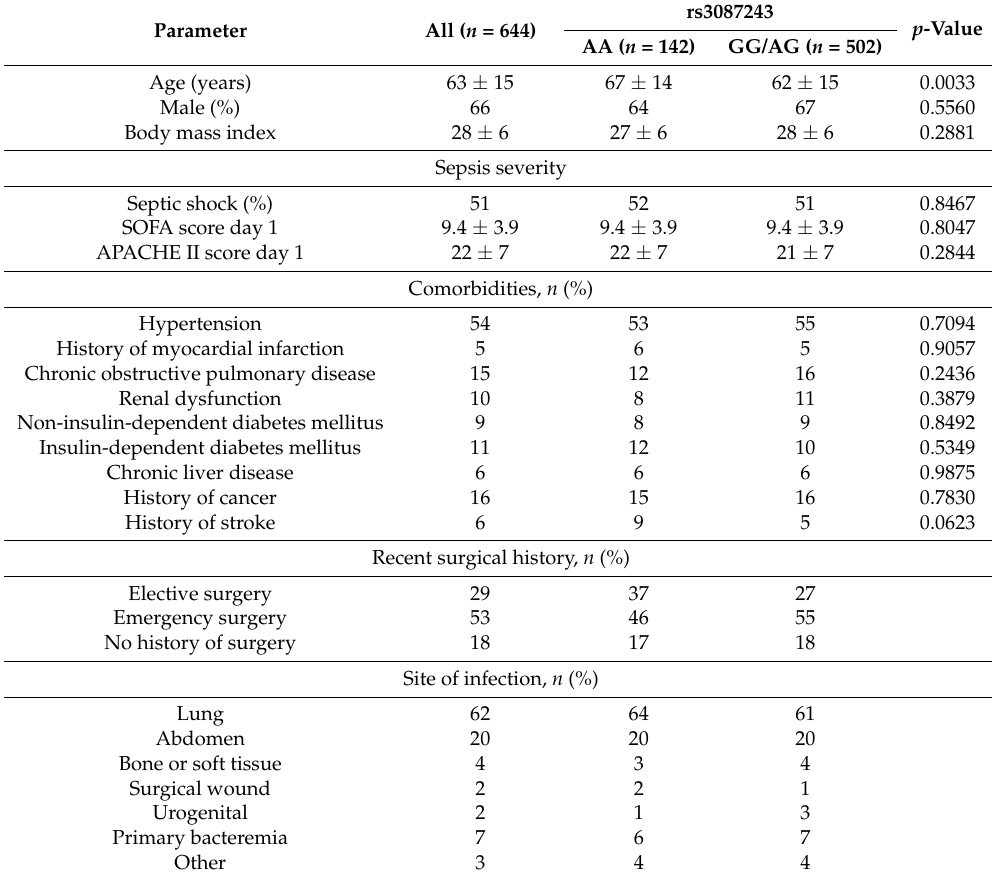
Table 1. Patient baseline characteristics with regard to the cytotoxic T lymphocyte-associated protein 4 (CTLA-4) rs3087243